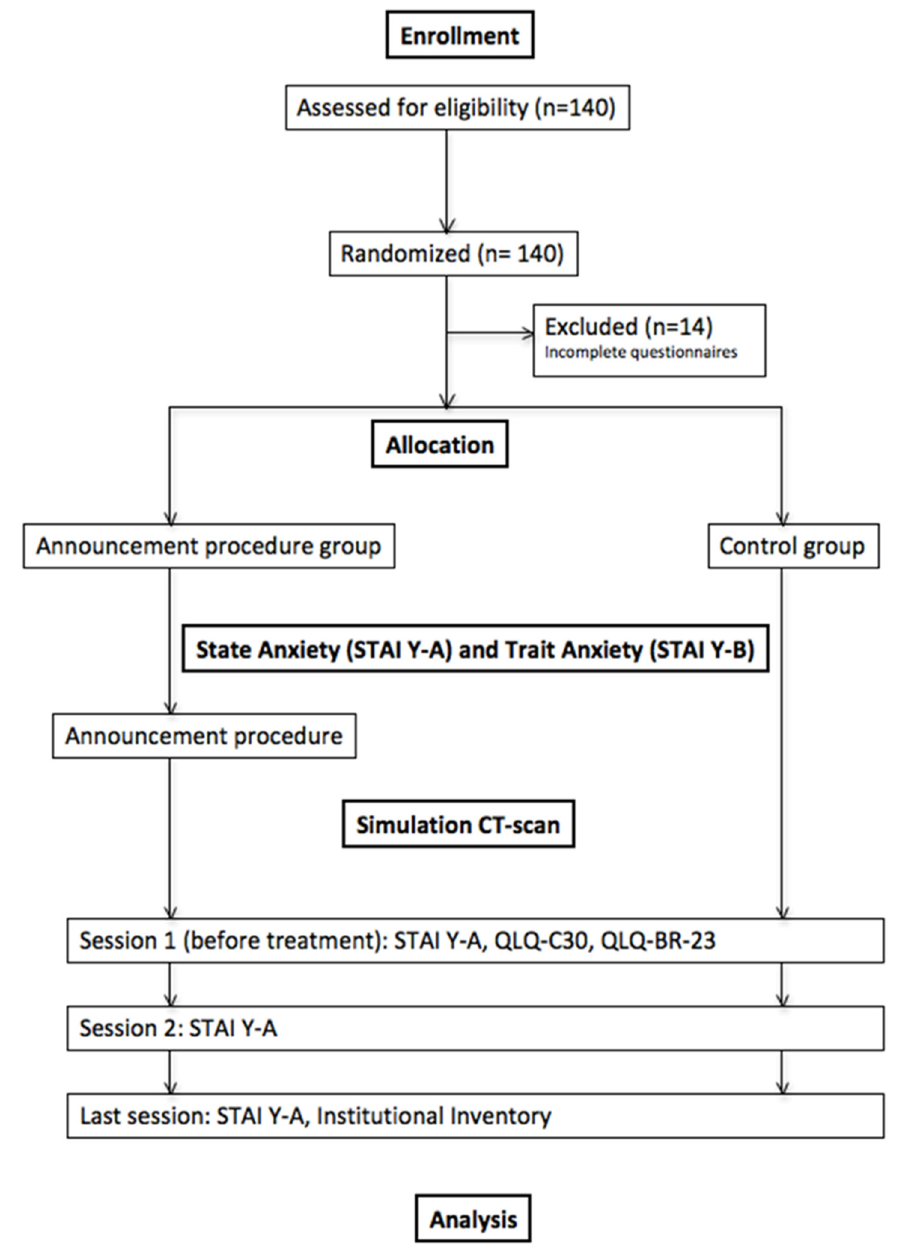
Figure 1. Trial design. Abbreviations: STAI Y-A = State Anxiety Inventory; STAI Y-B = Trait Anxiety Inventory; QLQ-C30 = EORTC (European Organization for Research and Treatment of Cancer) core quality of life questionnaire; QLQ-BR-23 = EORTC Quality of Life Questionnaire—Breast Cancer Module.